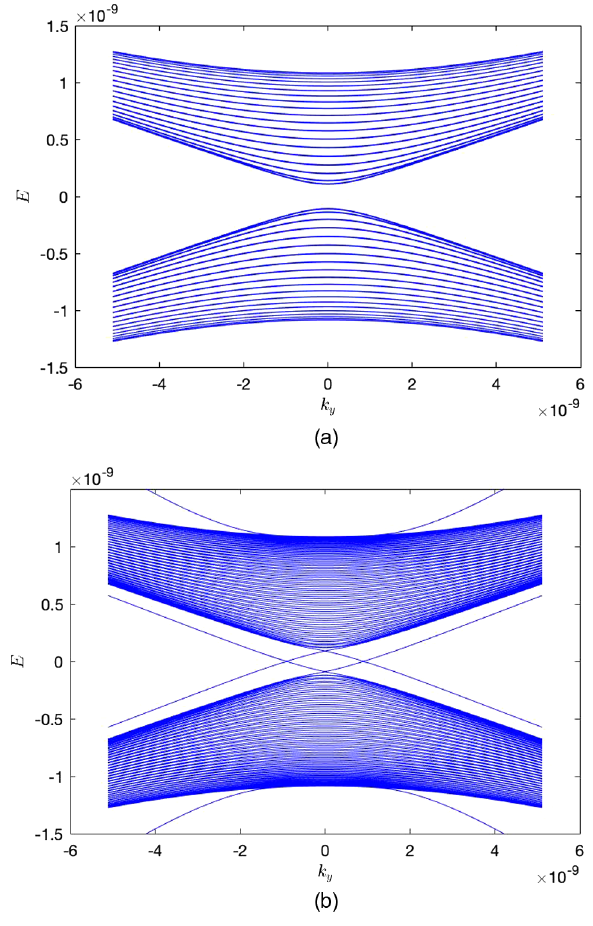
FIG. 7. The gapped Dirac spectrum from a numerical calcu- lation near κ ¼ 8 Q . We use the lattice model in Eqs. (3.27) and (3.28), with t ¼ 1 and μ ¼ 1 . 9 . The chemical potential is very close to the band bottom; thus, the system is quasicontinuous, k ≪ 2 π =a . Panel (a) is obtained by the periodic boundary F condition in the x direction, while panel (b) is from the open boundary condition. From counting the number of the localized edge modes in panel (b), such a phase has a Chern number C ¼ 2 . The smallness of the energy eigenvalues comes from the extreme tight-binding limit we take, q ≫ Q , which ensures a quantitative match with analytical